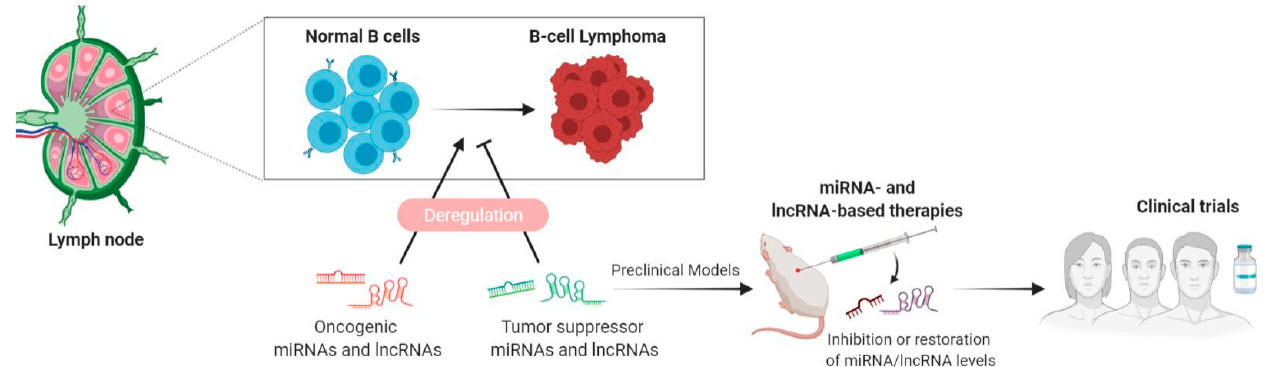
Figure 1. Decoding ncRNA biology from the bench to bedside in lymphoma. Deregulation of miRNAs and lncRNAs has been shown to play an important role during the process of B-cell lymphomagenesis. MiRNAs and lncRNAs can function both as oncogenes and as tumor suppressor genes. The study of altered miRNA/lncRNA expression will permit the identification of potential candidates to be use as therapeutics (to restore tumor-suppressive miRNAs/lncRNAs) or as therapeutic targets (to inhibit the levels of oncogenic miRNAs/lncRNAs) to be tested first in preclinical models and in subsequent clinical trials in lymphoma patients.